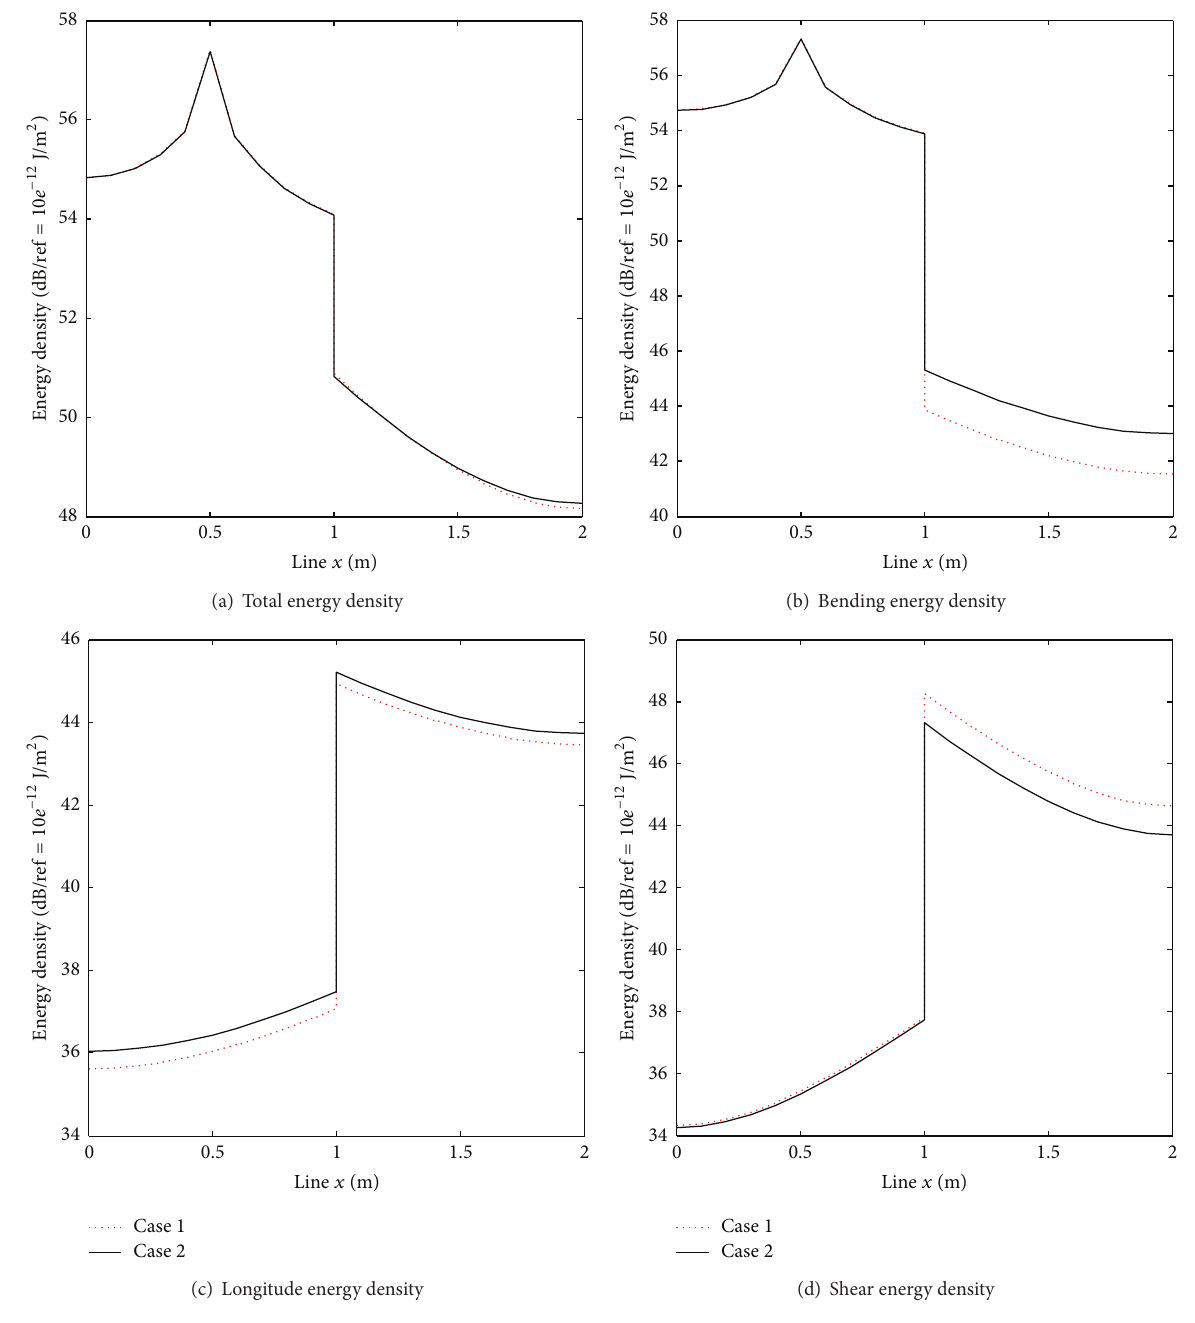
Figure 14: Comparison of energy density along dotted line between case 1 and case